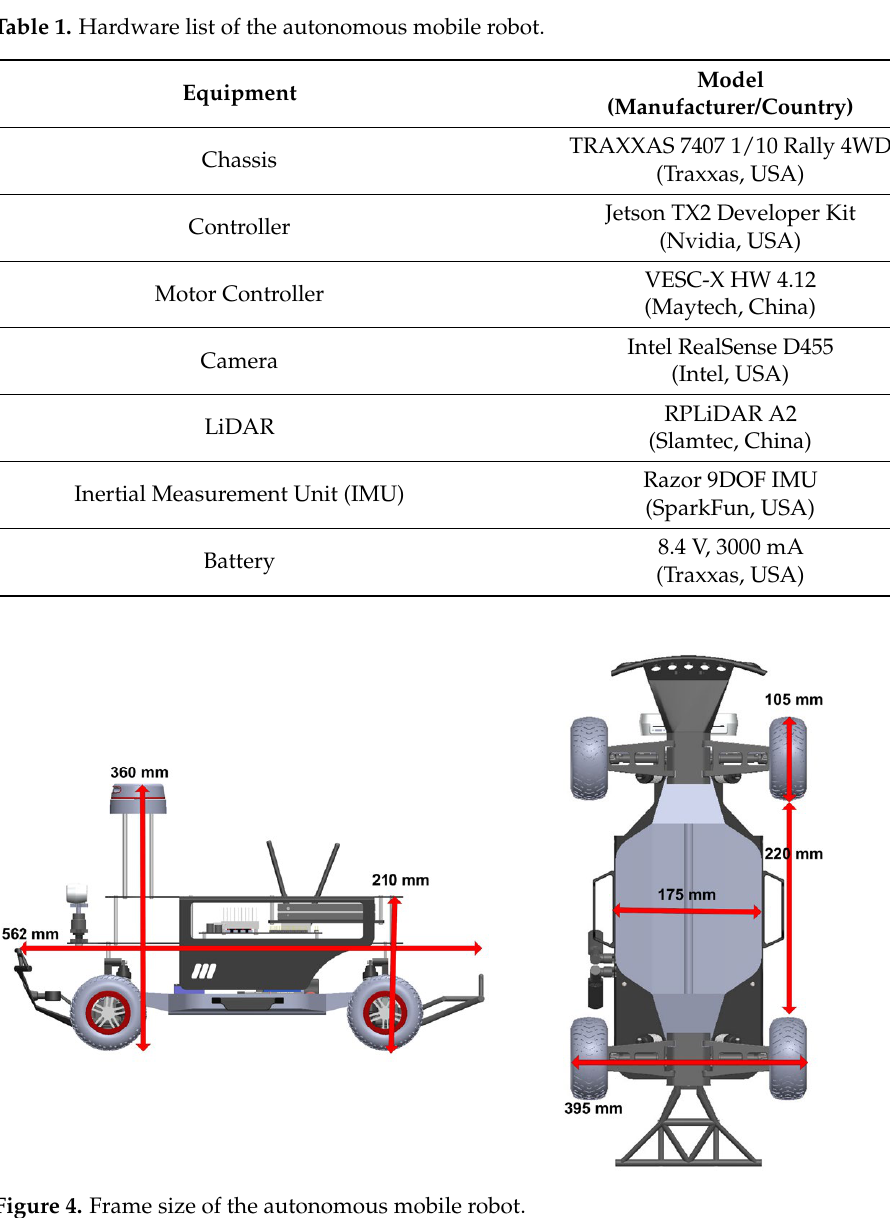
Table 1. Hardware list of the autonomous mobile robot.